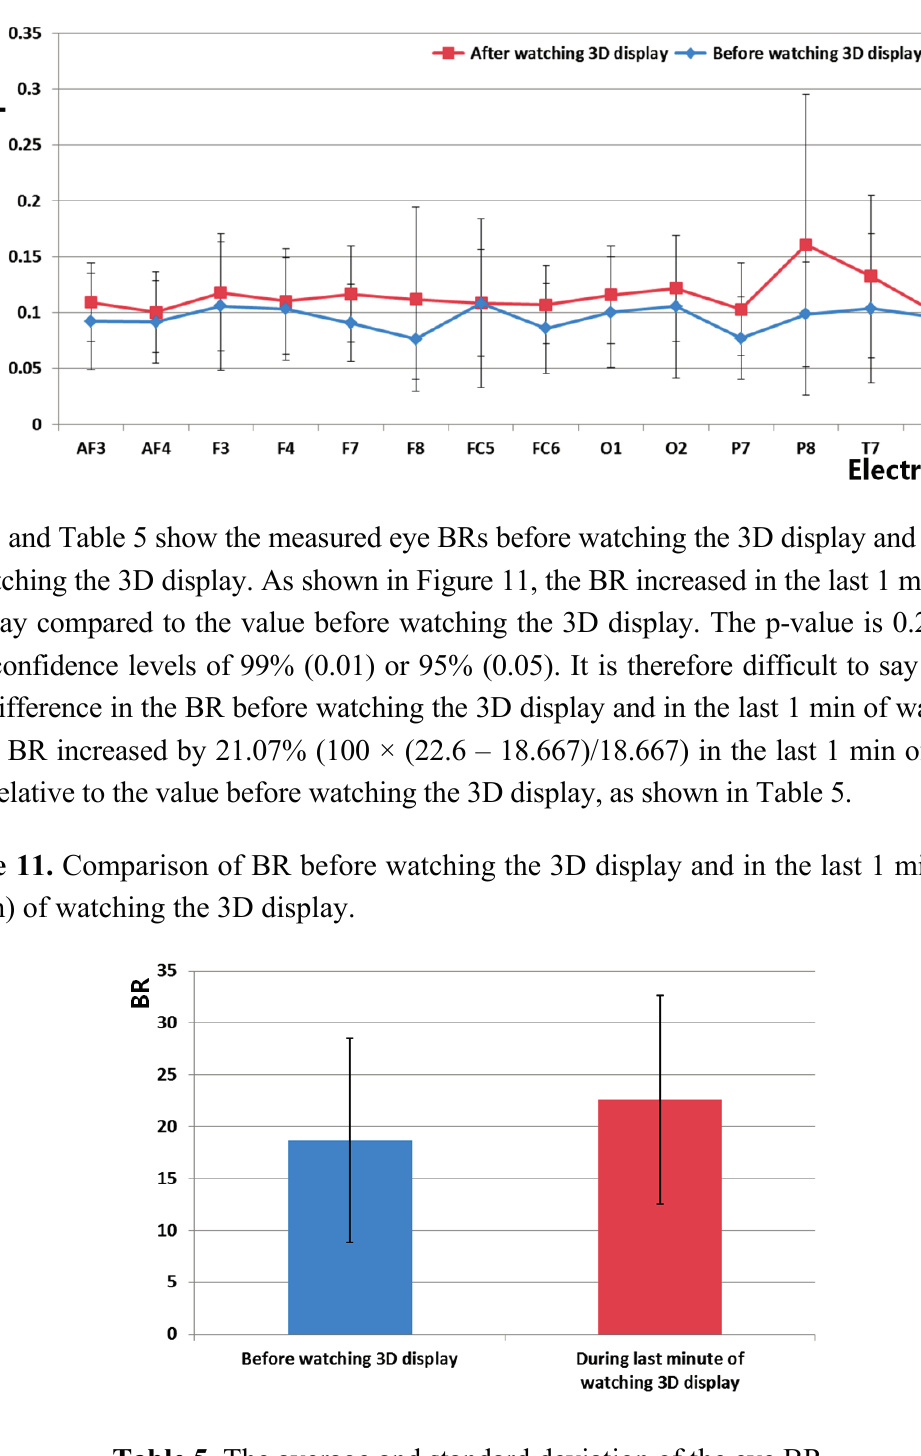
Figure 10. Comparisons of beta band of EEG data before and after watching 3D display.